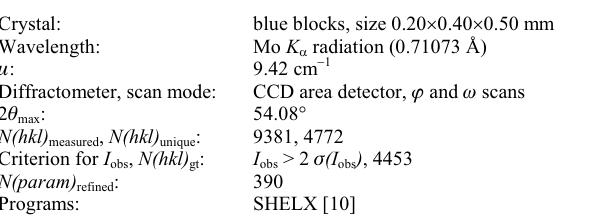
Table 1. Data collection and handling.